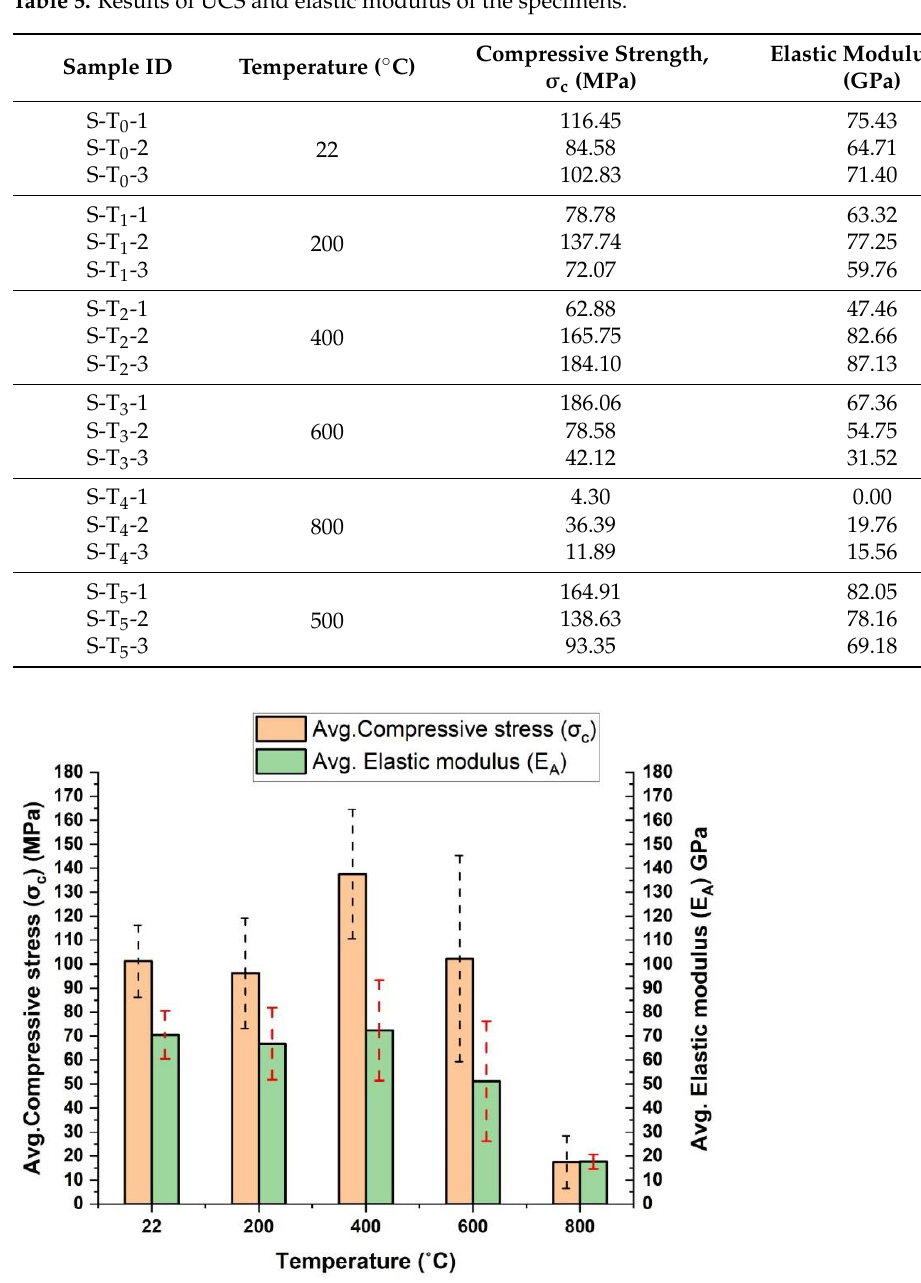
Figure 15. The average compressive stress and elastic modulus for the investigated samples at different temperatures, red and black dotted lines represent uncertainties in stress and elastic modulus. Table 5. Results of UCS and elastic modulus of the specimens.